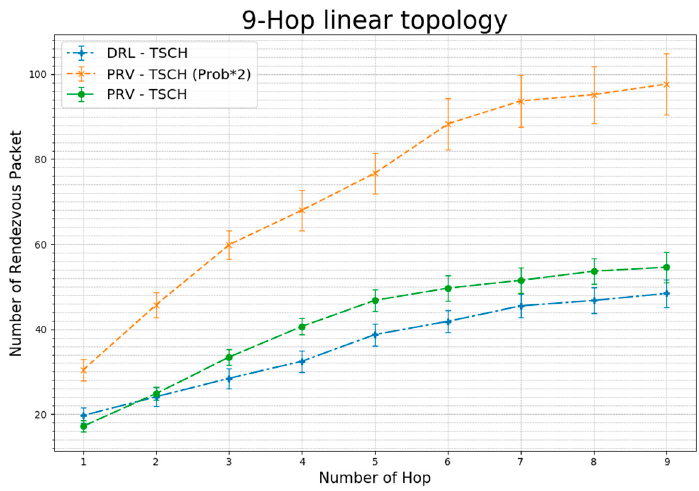
Figure 14. Average Number of Rendezvous Packets Transmitted per Hop Using 9-Hop Linear Topology (standard error).